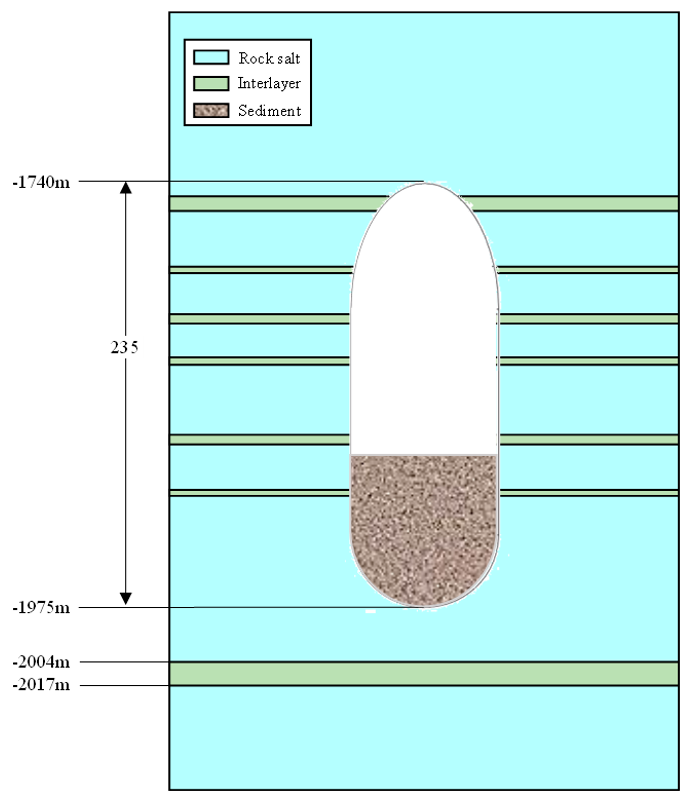
Figure 4. Schematic diagram of the target salt formation and the cavern shape for the construction of SSTW gas storage for Pingdingshan salt mine.